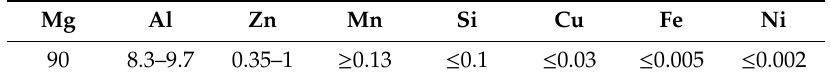
Table 1. Chemical composition of UNS M11917 (AZ91D-F) magnesium alloy in % of mass.